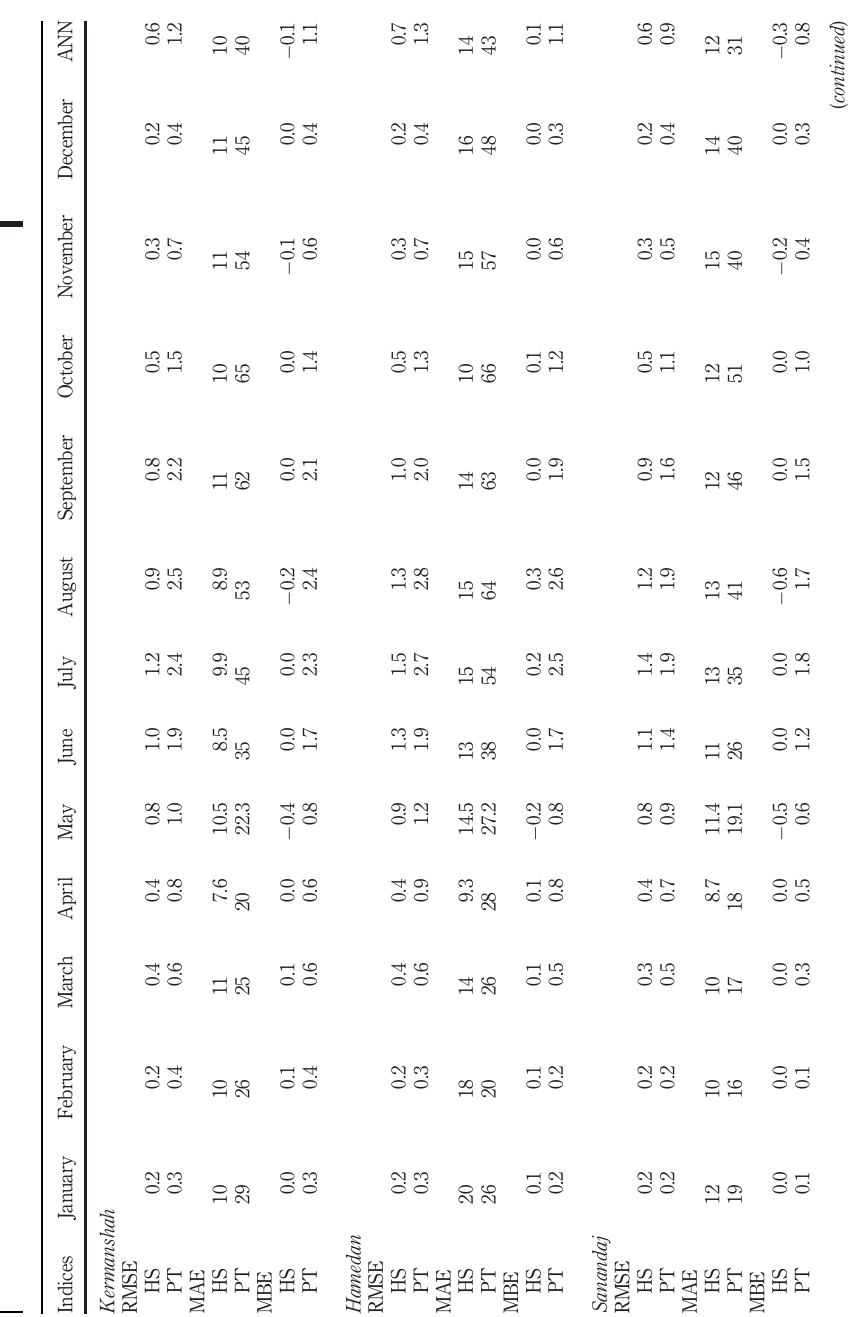
Table IV. Evaluating indices ETP estimation methods